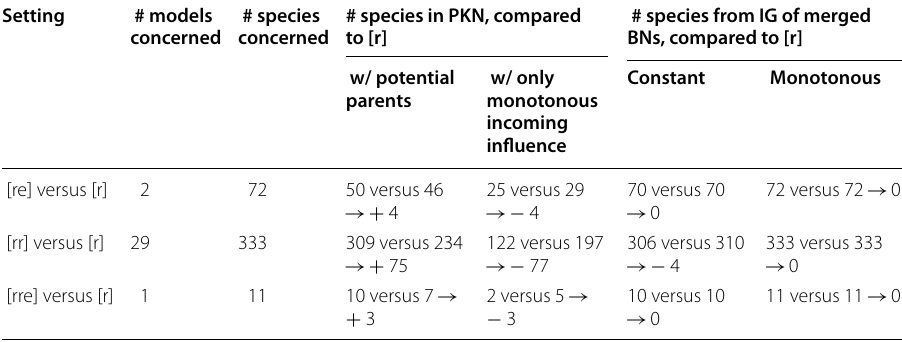
Table 5 Impact of the setting on the search space and synthesised functions in terms of monotonicity and constancy